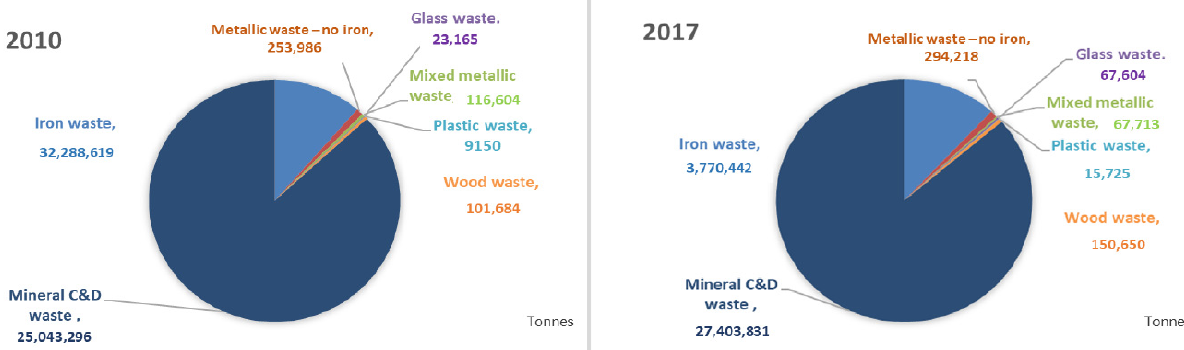
Figure 10. C&D waste material prepared to be recycled (tonnes). Source: Own elaboration from ISPRA